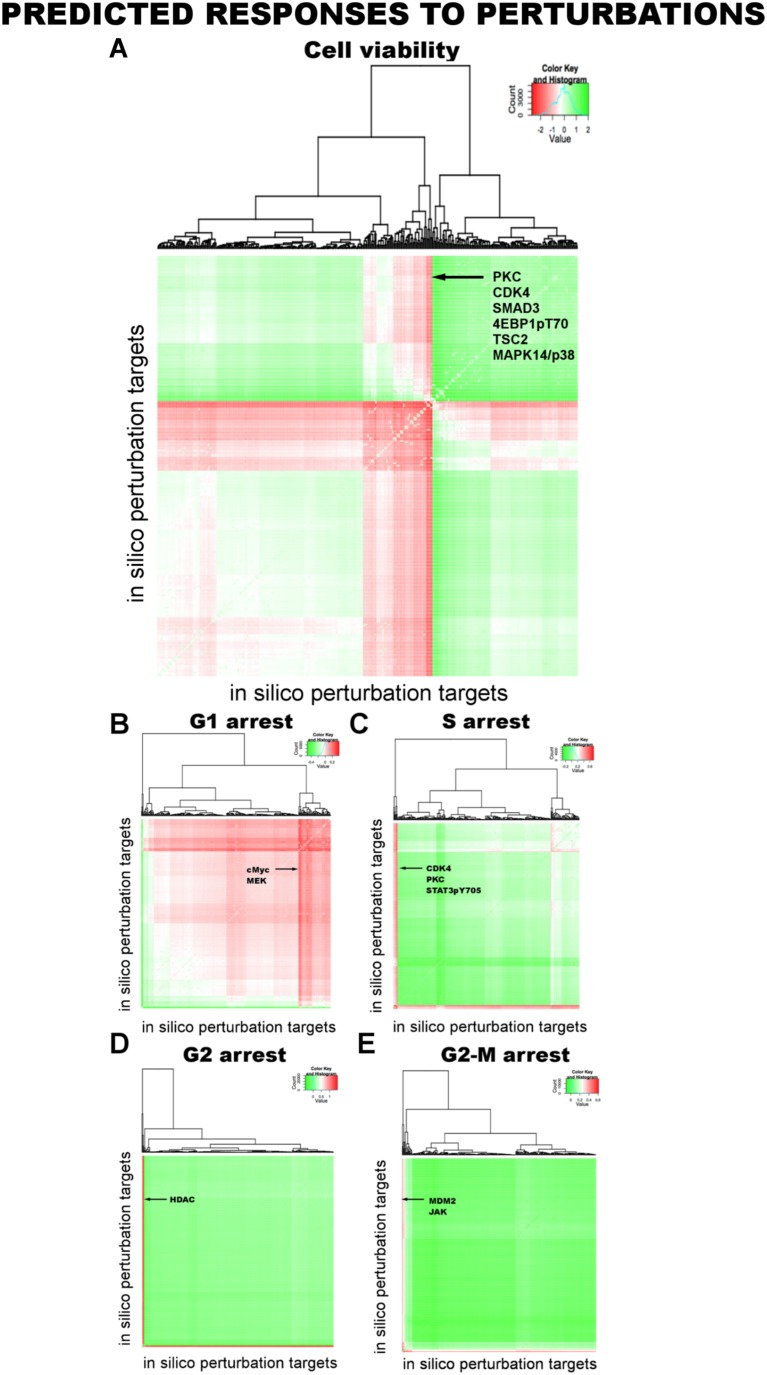
Prediction of phenotypic responses to in silico combinatorial perturbations.We computationally predicted cell viability and cell cycle arrest (G1, S, G2, and G2M) in response to combinatorial perturbations on all proteomic nodes in the network models (see Table 1 and Figures 5, 6). In silico perturbations include paired combinations of 94 perturbations in four different perturbation strengths (equivalent to IC0-20-40-60-80 with respect to the basal level of a particular node) leading to more than 70,000 unique perturbation conditions. Each in silico perturbation is applied to 4000 inferred network models. This leads to a simulation of ∼28 million unique conditions for 99 different readouts and nearly a 2.8 billion total predicted readouts over all models, a scale inaccessible by most experimental screening methods. The heatmaps display the phenotypic response landscape to combinatorial perturbations. Each data point on the heatmaps is the response to a perturbation averaged over predictions from 4000 network models. (A) Cell viability response to combinatorial perturbations. The desired response from a perturbation is reduction in cell viability (red: decreased cell viability, green: increased cell viability). (B–E) Same as in A but for cell cycle progression phenotypes. For cell cycle phenotypes, the desired response is an increase in the cell cycle arrest (red: increased cell cycle arrest. green: decreased cell cycle arrest).